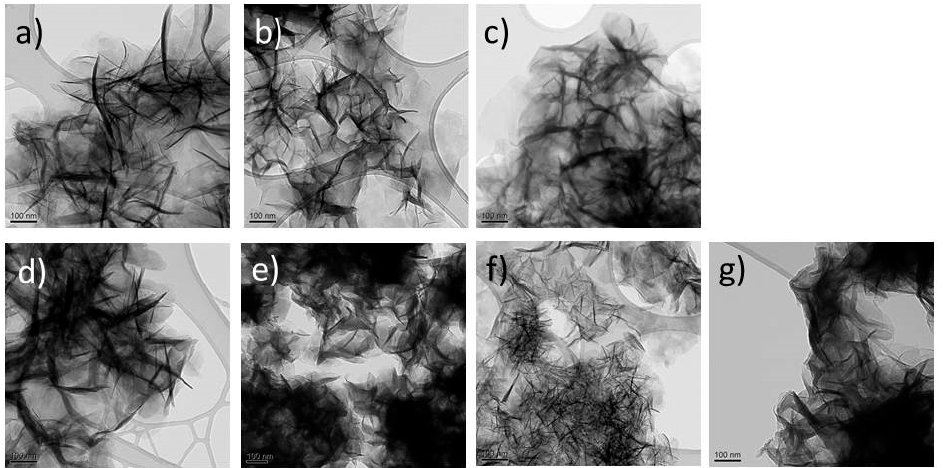
Figure 2. Representative TEM images of selected Mg 1 − x Al x (OH) 2 ( A n − ) x / n mH 2 O LDHs. A n − = NO 3 − , x = ( a ) 0.20, ( b ) 0.25, ( c ) 0.33. A n − ( x = 0.25), ( d ) Cl − , ( e ) I − , ( f ) CO 32 − , ( g ) SO 42 − . All samples shows the typical house ‐ of ‐ card morphology, and the particles have similar platelet thickness and size.